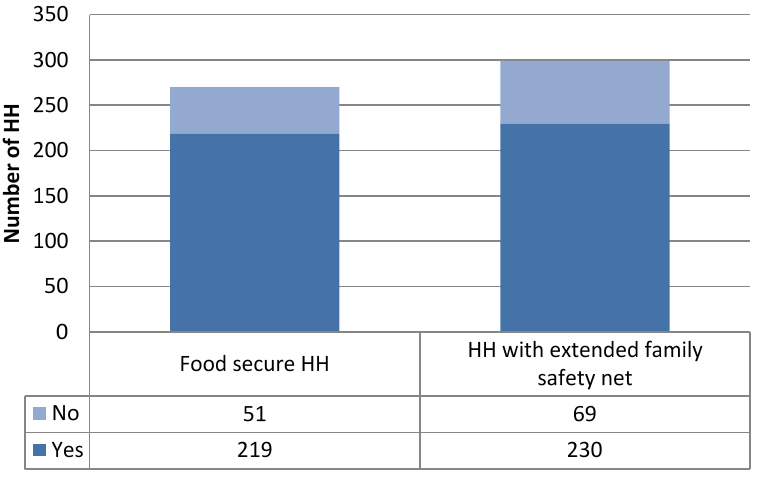
Figure 9. Perceptions on food security, safety nets, and external